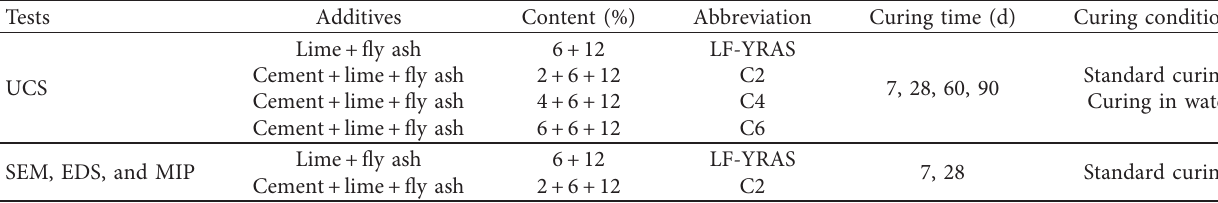
Table 3: Test scheme.